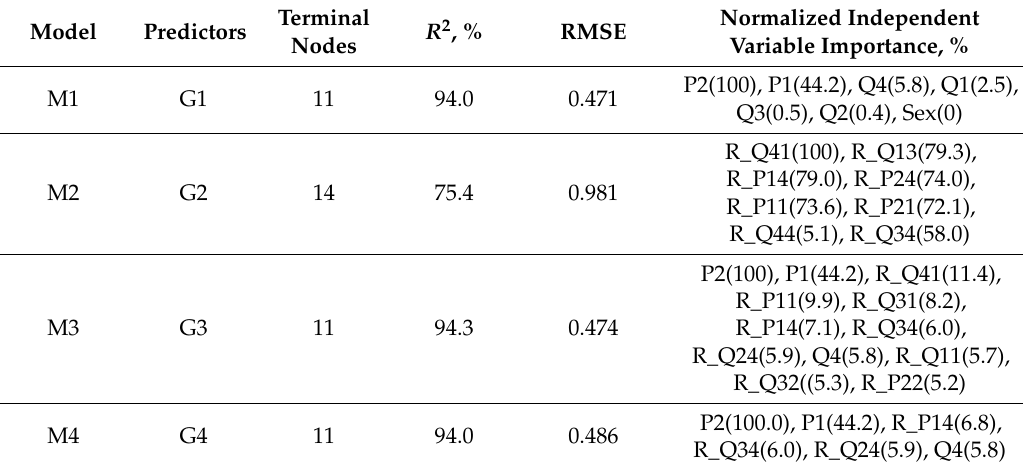
Table 5. Summary statistics of regression CART models for Score